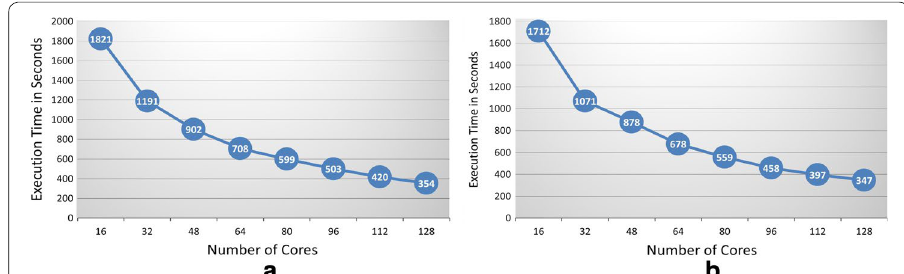
Fig. 8 Index generation time of ( a ) hg19 and ( b ) OryKun2 genome for StreamAligner